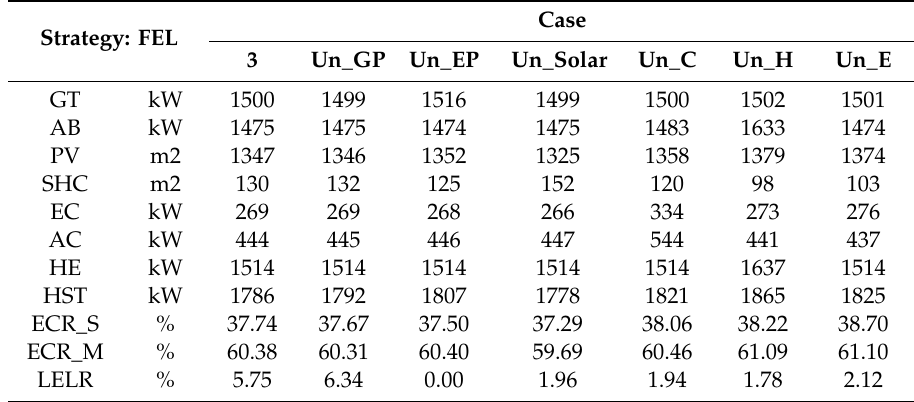
Table 8. Optimal design under case 3 and the single uncertain cases.